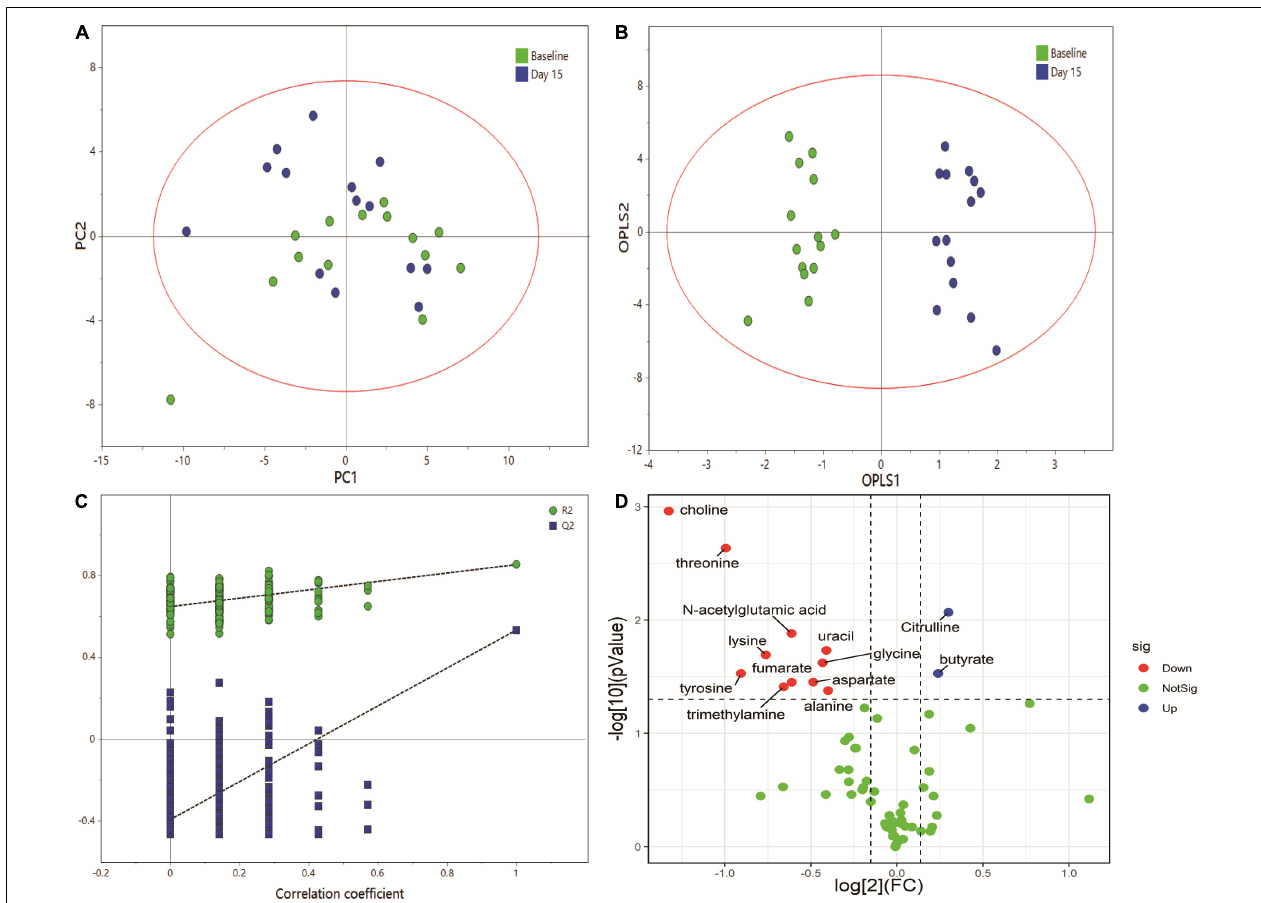
FIGURE 4 | Multivariate data analysis of fecal 1 H NMR data. (A) Score plot of PCA model, (B) score plot of OPLS model, (C) permutation test (permutation no.: 200), (D) The volcano plot of metabolites identified by 1 H